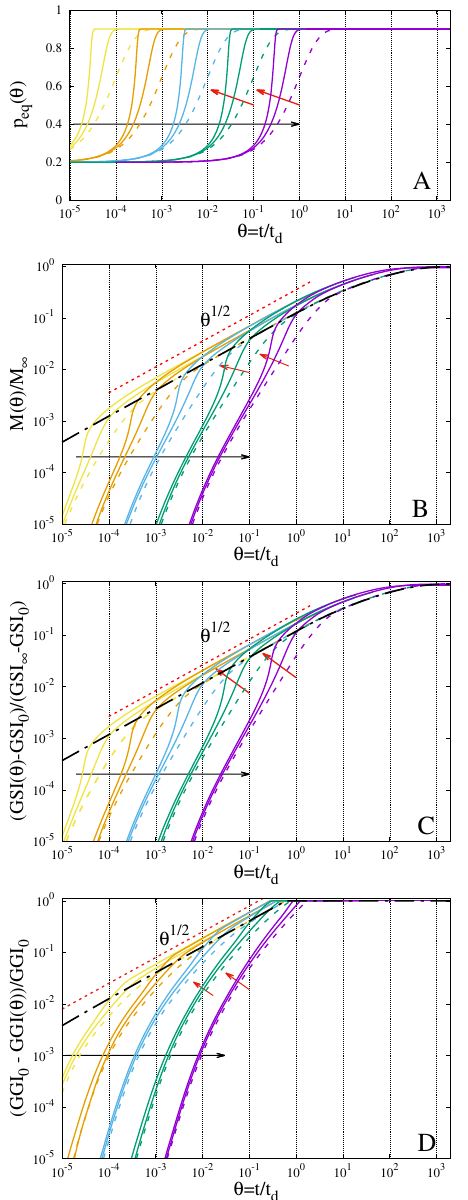
Figure 4. Temporal evolution of the boundary solvent volume fraction p eq ( θ ) ( A ), the normalized amount of absorbed solvent ( B ), the rescaled Gel–Solvent interface ( C ), and the rescaled Glass–Gel interface ( D ). Continuous lines represent the behaviour for a variable relaxation time ( γ r = log10, log100) and constant diffusion coefficient ( γ d = γ r /2). Dashed lines represent the behaviour for a constant relaxation time and constant diffusivity (same data shown in Figure 3A–D). Larger black arrows indicate increasing values of De 0 = 10 − 4 ,10 − 3 ,10 − 2 ,10 − 1 ,10 0 . Smaller red arrows indicate increasing values of γ r